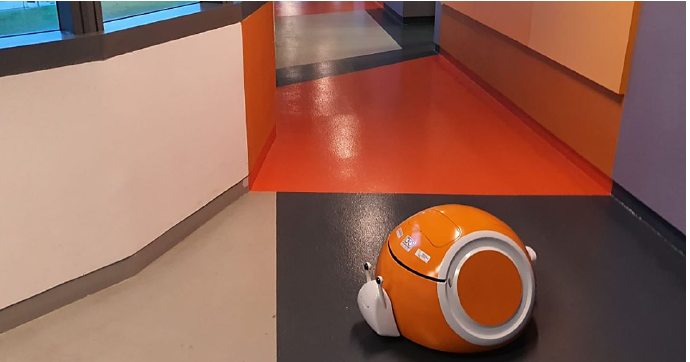
Figure 1. Autonomous steam mopping and disinfection robot